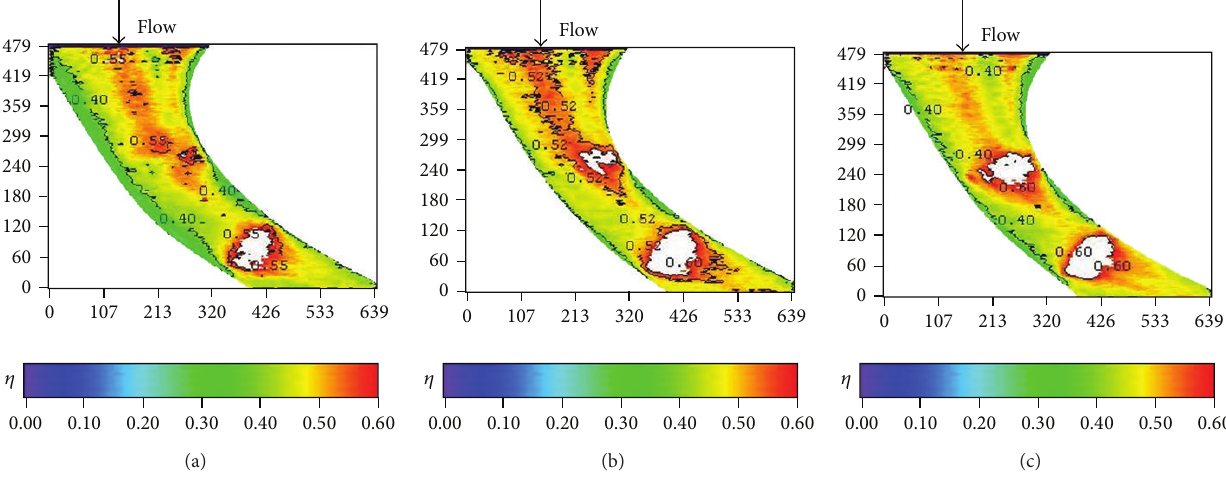
Figure 12: Effect of blowing ratio on local effectiveness at low turbulence intensity ( 𝑆/𝐶 = 0 %, Re = 124000 , and T . I . = 1.8 %). (a) 𝑀 = 0.5 . (b) 𝑀 = 1 . (c) 𝑀 = 2 .